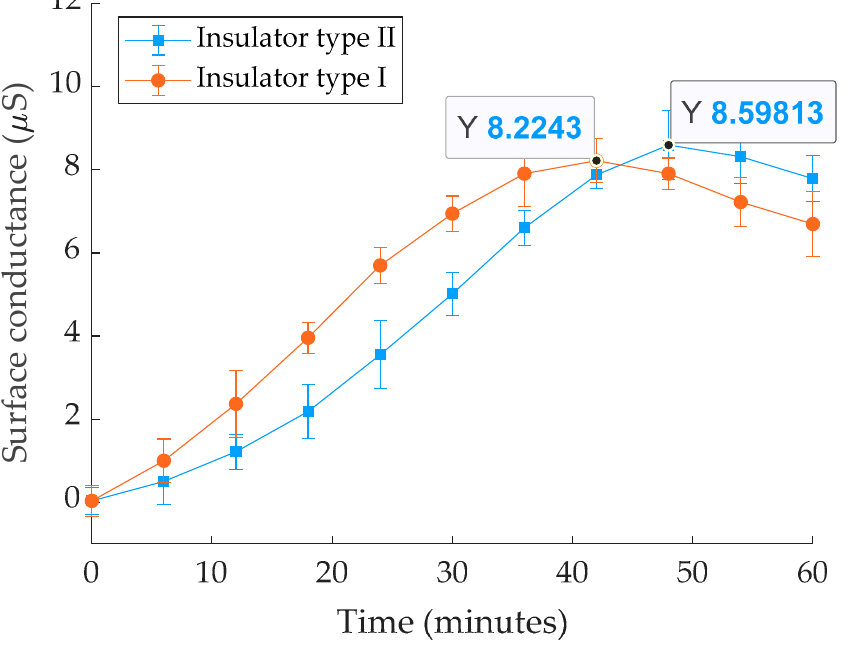
Figure 3. Leakage conductance behavior for insulator type I and insulator type II with respect to time, under fog and ESDD = 0.15 mg/cm 2 . Table 2. Maximum values of conductance for five tests, average conductance, and standard deviation of surface conductance when the insulators were saturated with